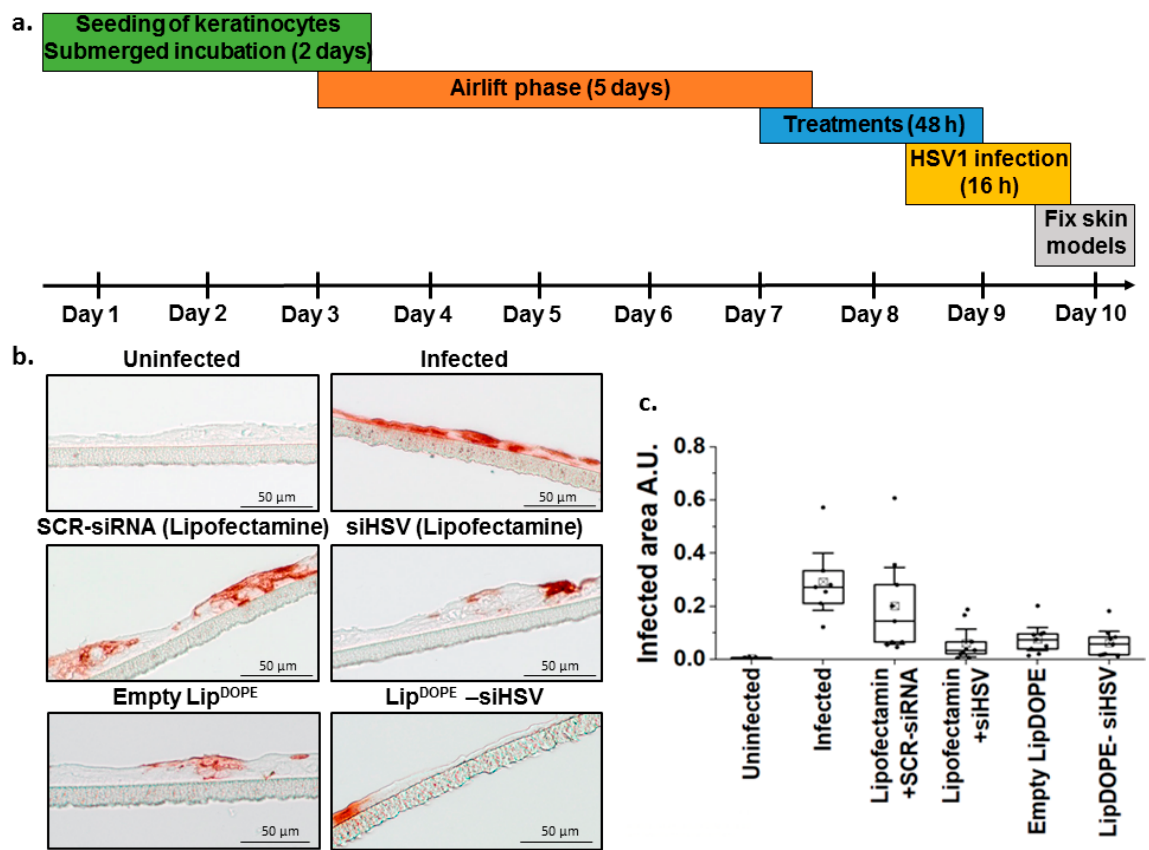
Figure 8. The antiviral effect of Lip DOPE -siHSV (DOTAP:siHSV N:P of 5:1) against HSV-1 infection in the 3D epidermis model of immortalized keratinocytes (HaCaT). ( a ) Illustration of the experi- mental setup. ( b ) Qualitative assessment of the treatments by immunohistochemistry of epidermis tissues treated with Lip DOPE -siHSV (2.5 µ g/mL), scrambled-siRNA (SCR) transfected by lipofec- tamine (1.5 µ g/mL) and empty Lip DOPE (negative controls), and siHSV transfected by lipofectamine (1.5 µ g/mL; positive control), in comparison to uninfected and untreated infected cells. The epider- mis tissues were infected with HSV-1 after 48 h and were analyzed after 16 h for tissue morphometry and integrity (scale bar = 50 µ m). ( c ) Quantification of the immunohistochemistry staining of three independent experiments (each experiment consisting of two or three individual skin models) is shown in ( b ) by calculating the infected area in the epidermis